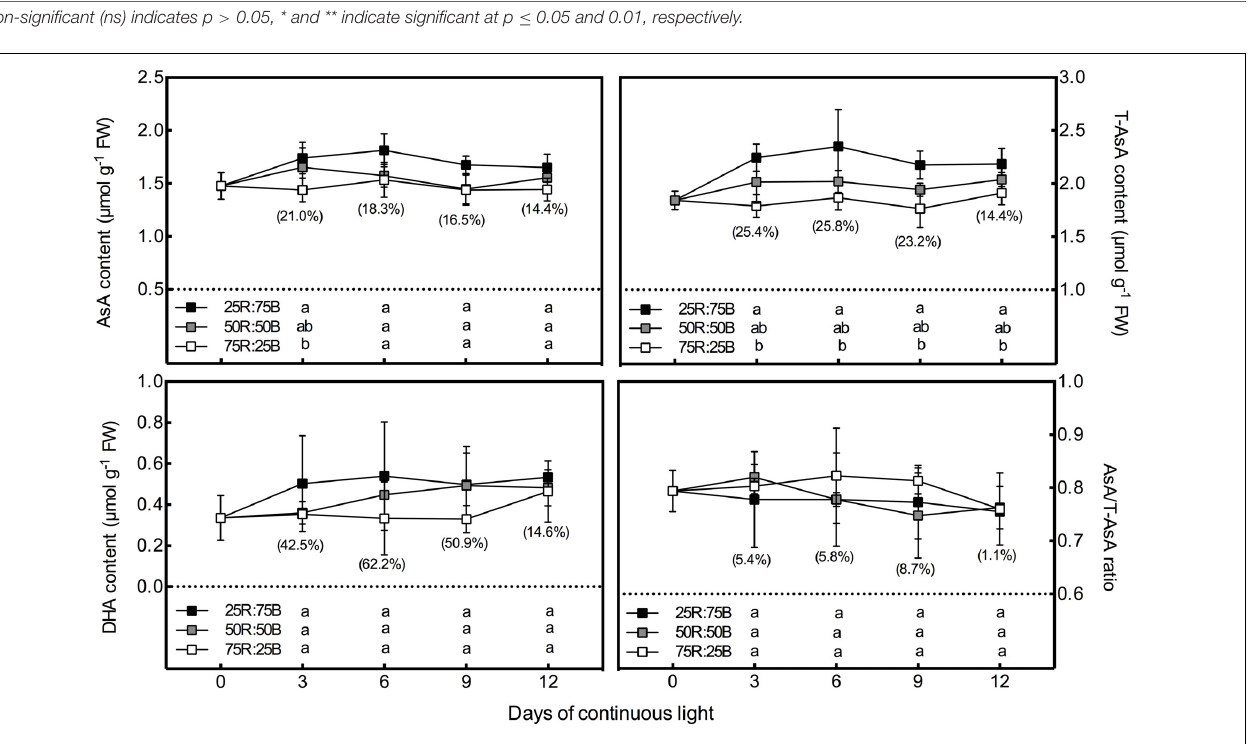
FIGURE 2 | Effects of the red:blue light ratio on the total ascorbate (T-AsA), ascorbate (AsA) and dehydroascorbate (DHA) contents as well as the AsA/T-AsA ratio in lettuce leaves under continuous light (200 µ mol · m – 2 · s – 1 ). Values and bars represent the means of four replicates ± SD. Different letters in the same column indicate significant differences at the p < 0.05 level according to Tukey test. Data in brackets were the increasing rate of the maximum value to the minimum value on the same